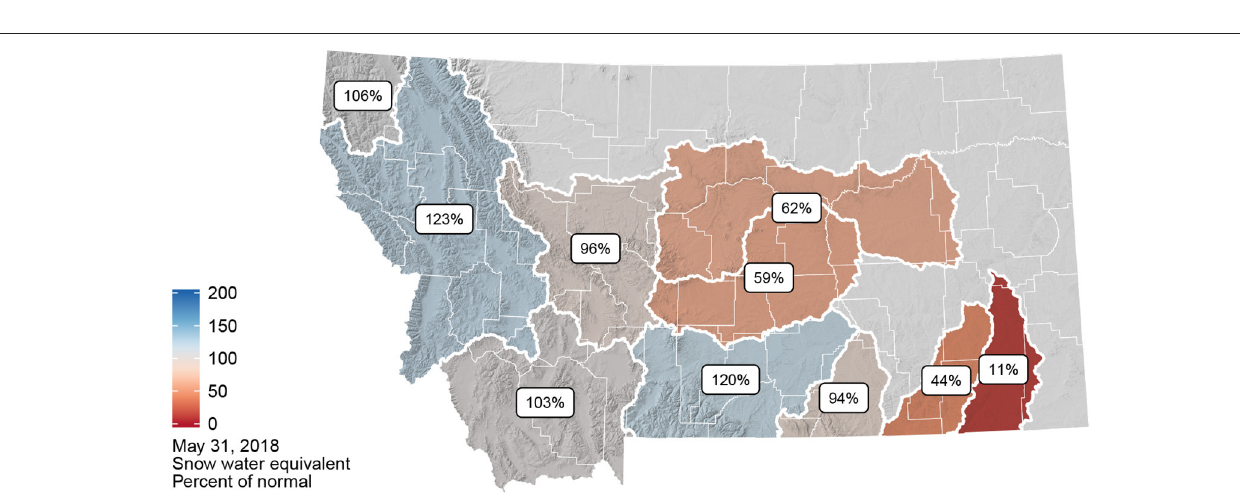
FIGURE 4 | Percent of normal snow water equivalent (SWE) on May 31, 2018. SWE is the amount of water contained within the snowpack. SWE is measured across the West by the USDA Natural Resources Conservation Service’s SNOTEL network of snow monitoring stations, aggregated spatially by hydrologic basins. The SWE percent of normal represents the current snow water equivalent found at selected SNOTEL sites in each hydrological basin compared to the normal value for those sites from 1981 to